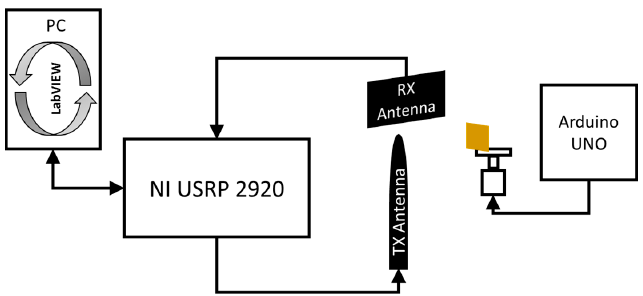
Figure 16. Setup diagram of the second experimental test.